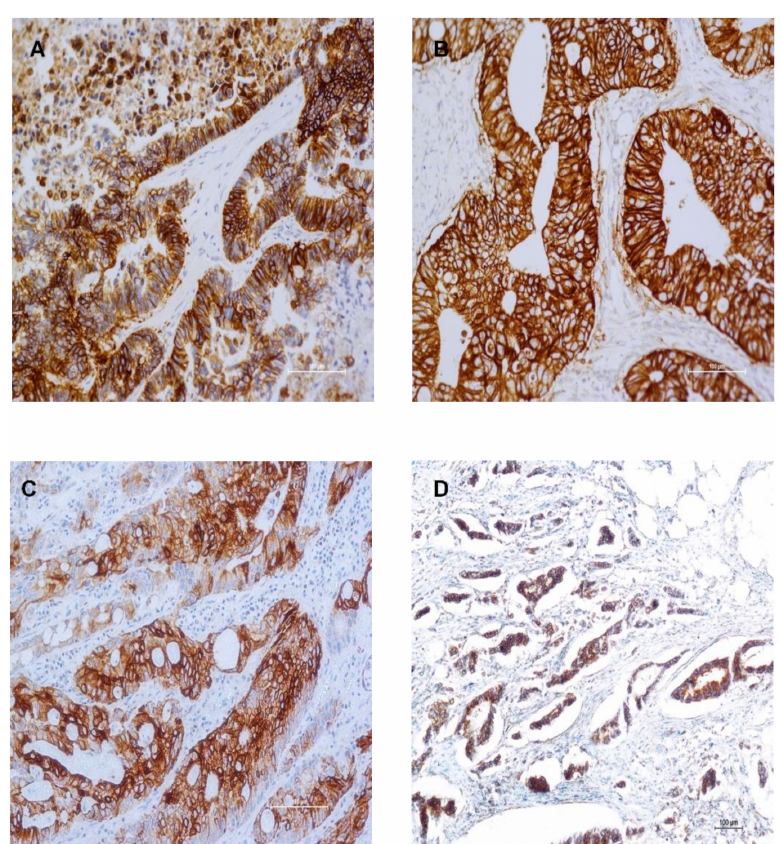
Figure 1. Immunostaining of Human Epidermal Growth Factor Receptor family members in mCRC specimens. Immunostaining of wild type EGFR (wtEGFR) ( A ), HER2 ( B ), HER3 ( C ), and HER4 ( D ) in formalin fixed paraffin embedded tumour sections stained immunohistochemically using the Ultra Discovery Autostainer as described